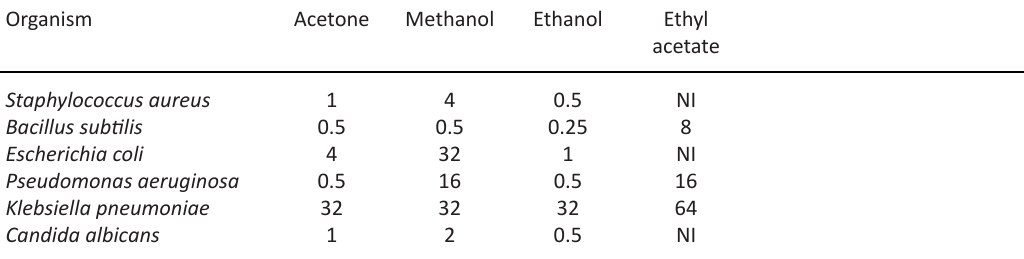
Table 3. Minimum inhibitory concentration of passion fruit pulp with seeds (mg/ml -1 ) Organism